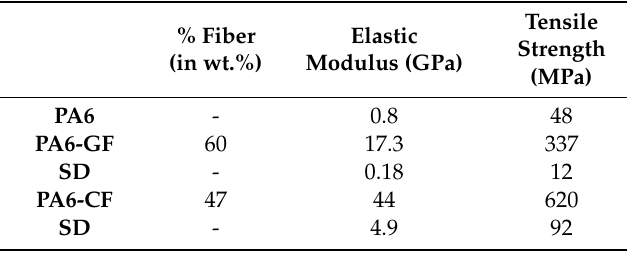
Table 3. Results of tensile tests for neat PA6 and reinforced PA6 with glass (GF) and carbon fibers (CF). Average values and standard deviations (SD) are also